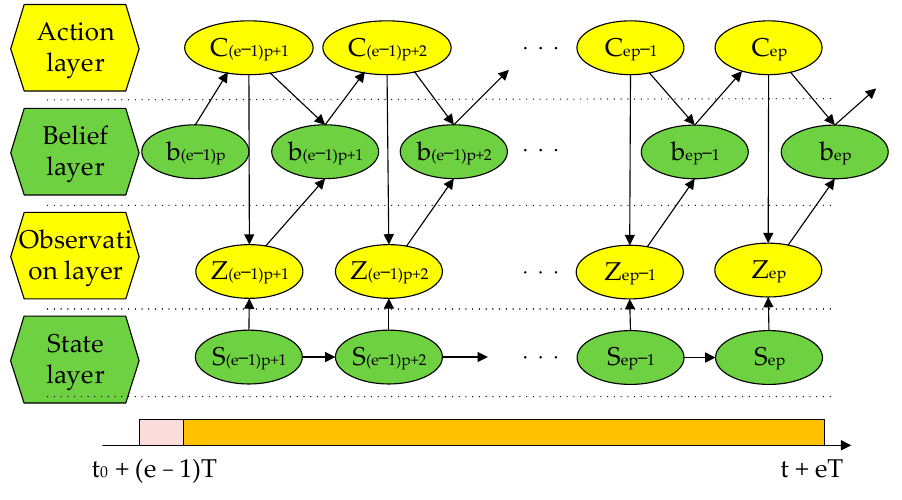
Figure 3. Single task cycle scheduling process.